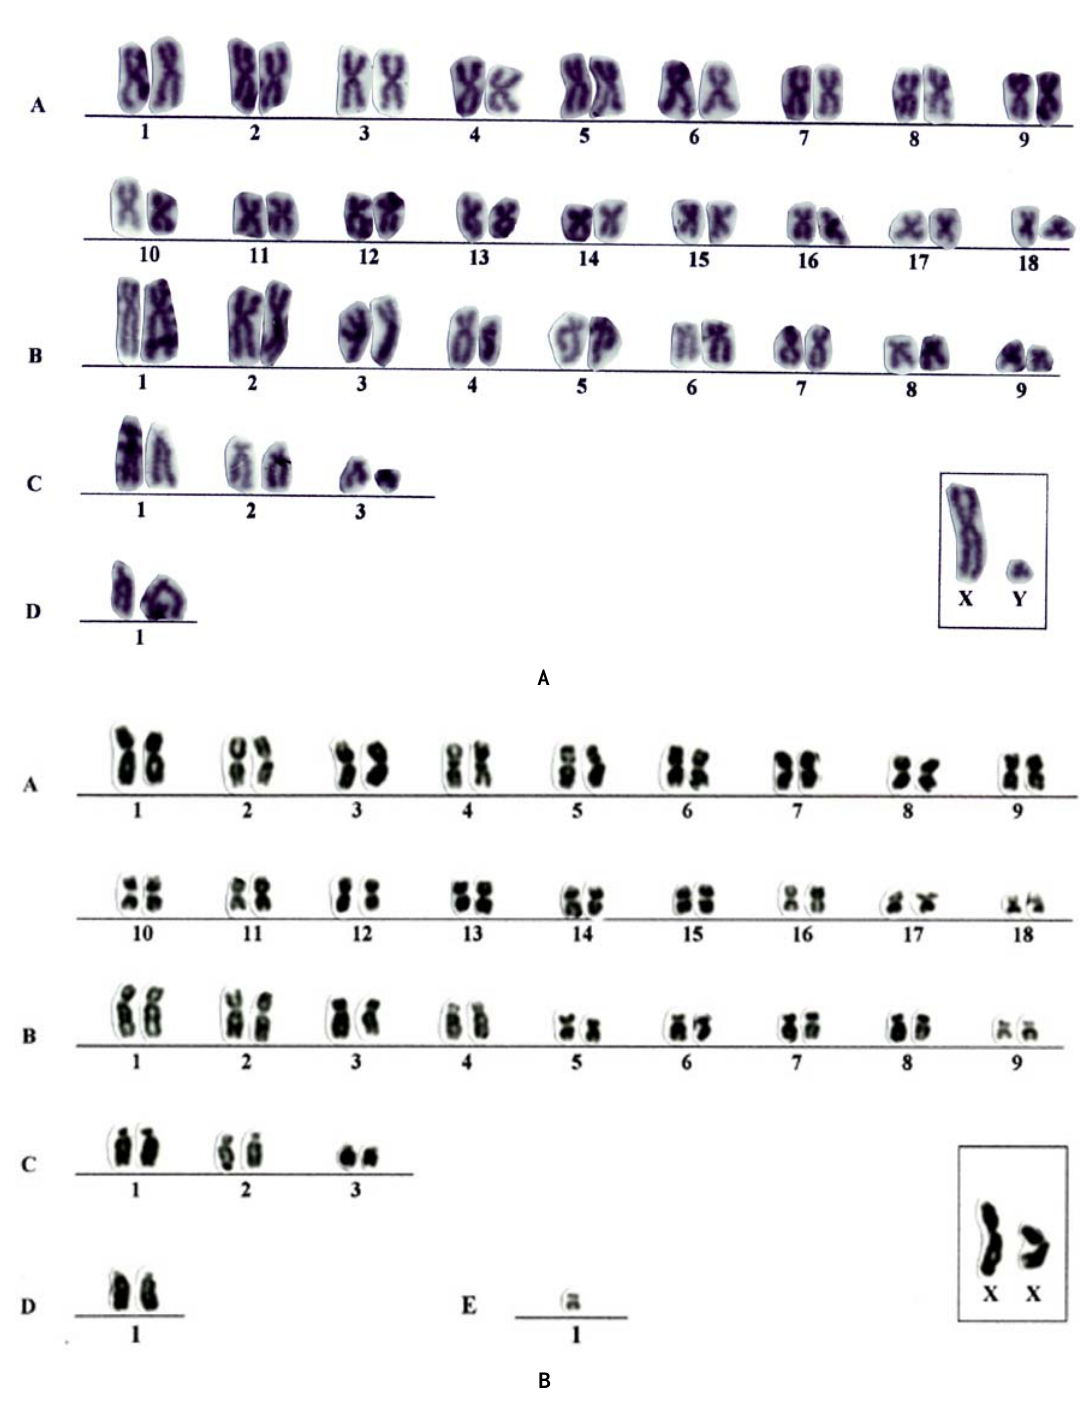
Fig. 2 – Karyotype of the lineage 2n=64 (marrow bone) and 2n=65 (lymphocytes culture) of D. leporina in conventional Giemsa stain. A) lineage 2n=64 from a male; B) lineage 2n=65 from a